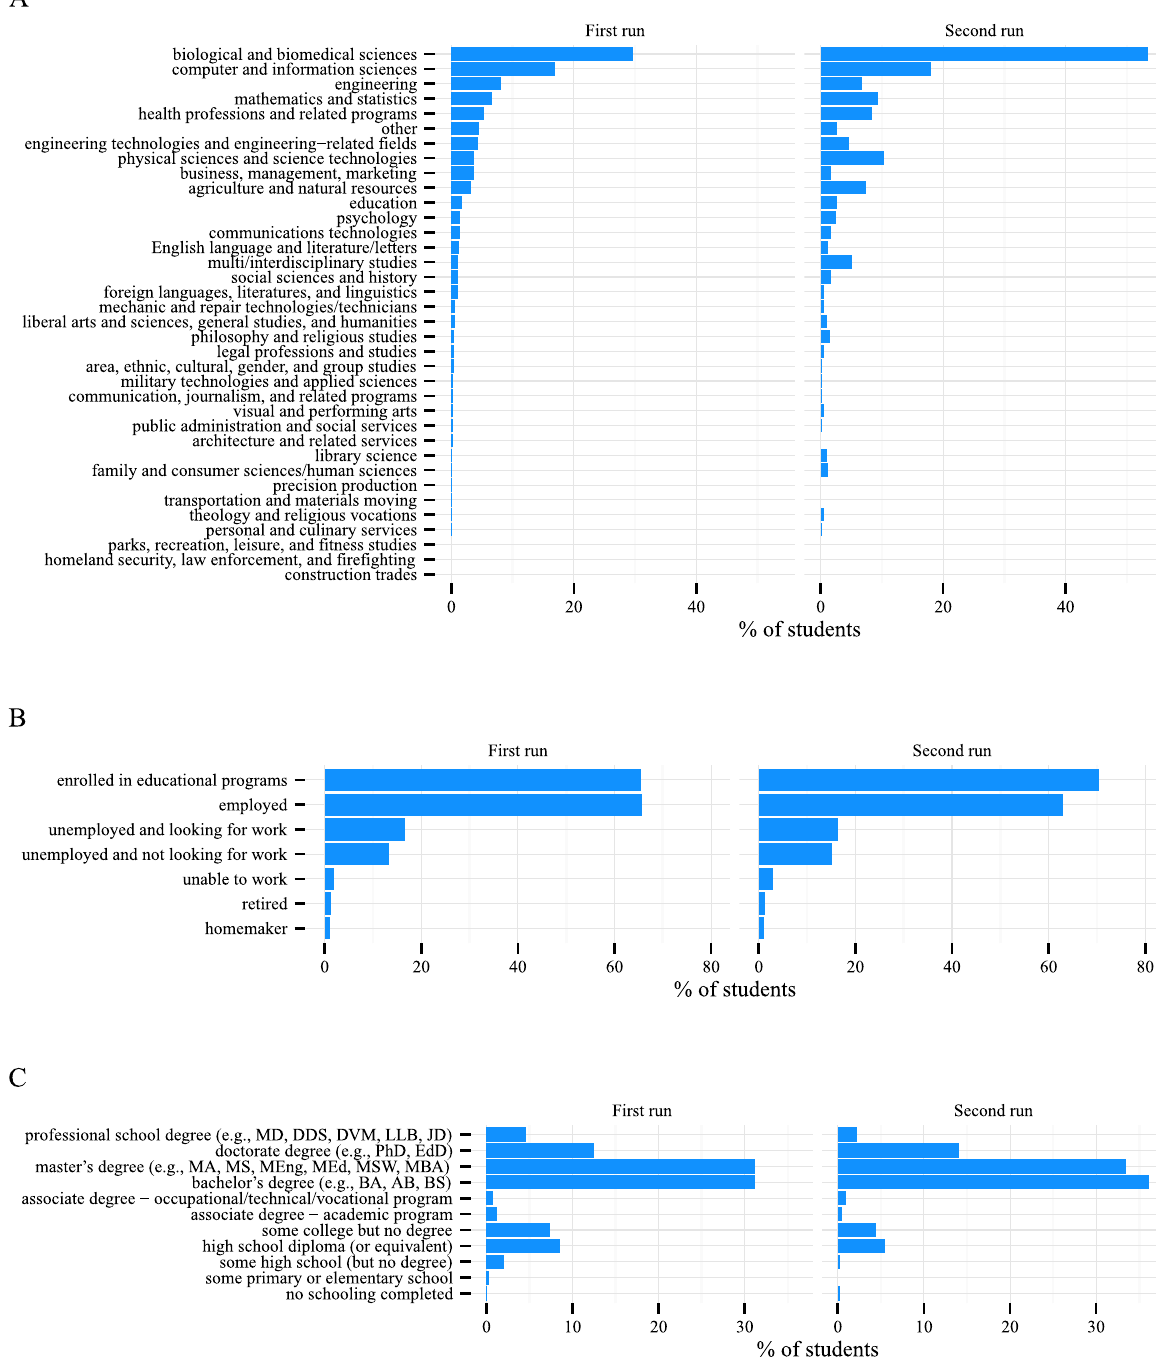
Figure 1. Students of the MOOC had diverse background. (A) Students came from a broad range of disciplines. (B) More than half of the students were currently enrolled in educational programs or were currently working. (C) Most students had acquired a Bachelor’s or Master’s